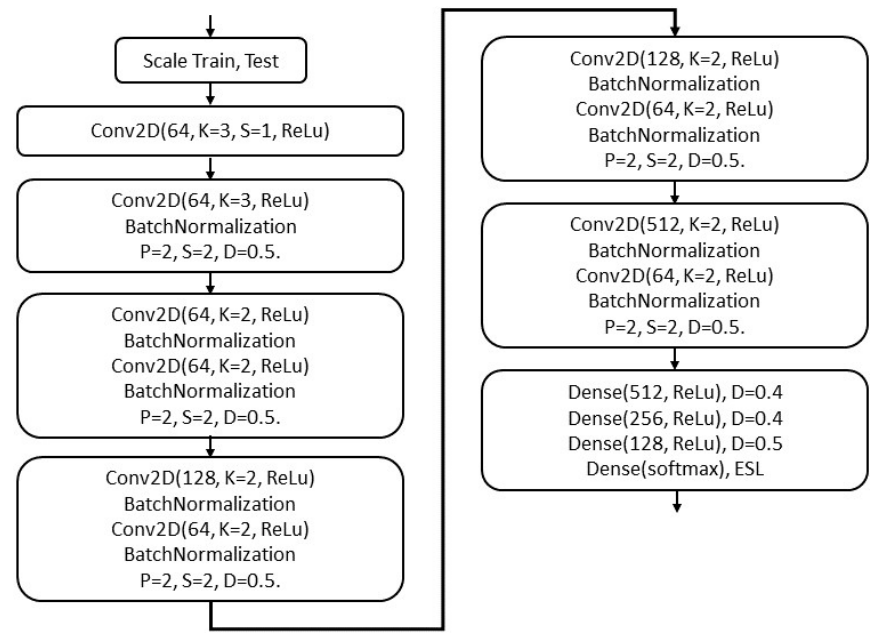
Figure 1. Neural network architecture implemented for automatic facial expression recognition.